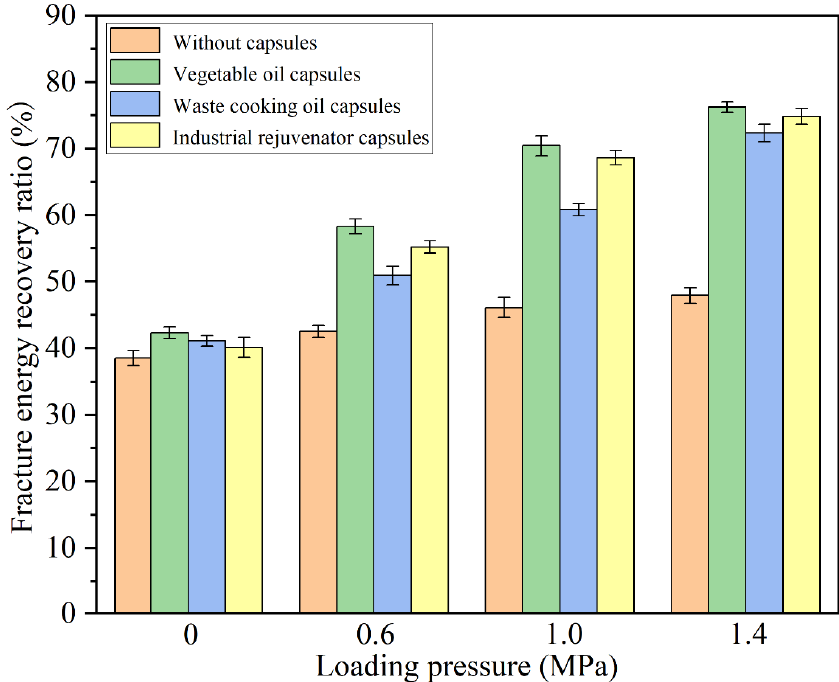
Figure 11. Fracture energy recovery ratios of the specimens containing different capsules under 10,000 cycles ’ compression loading of different stress levels.